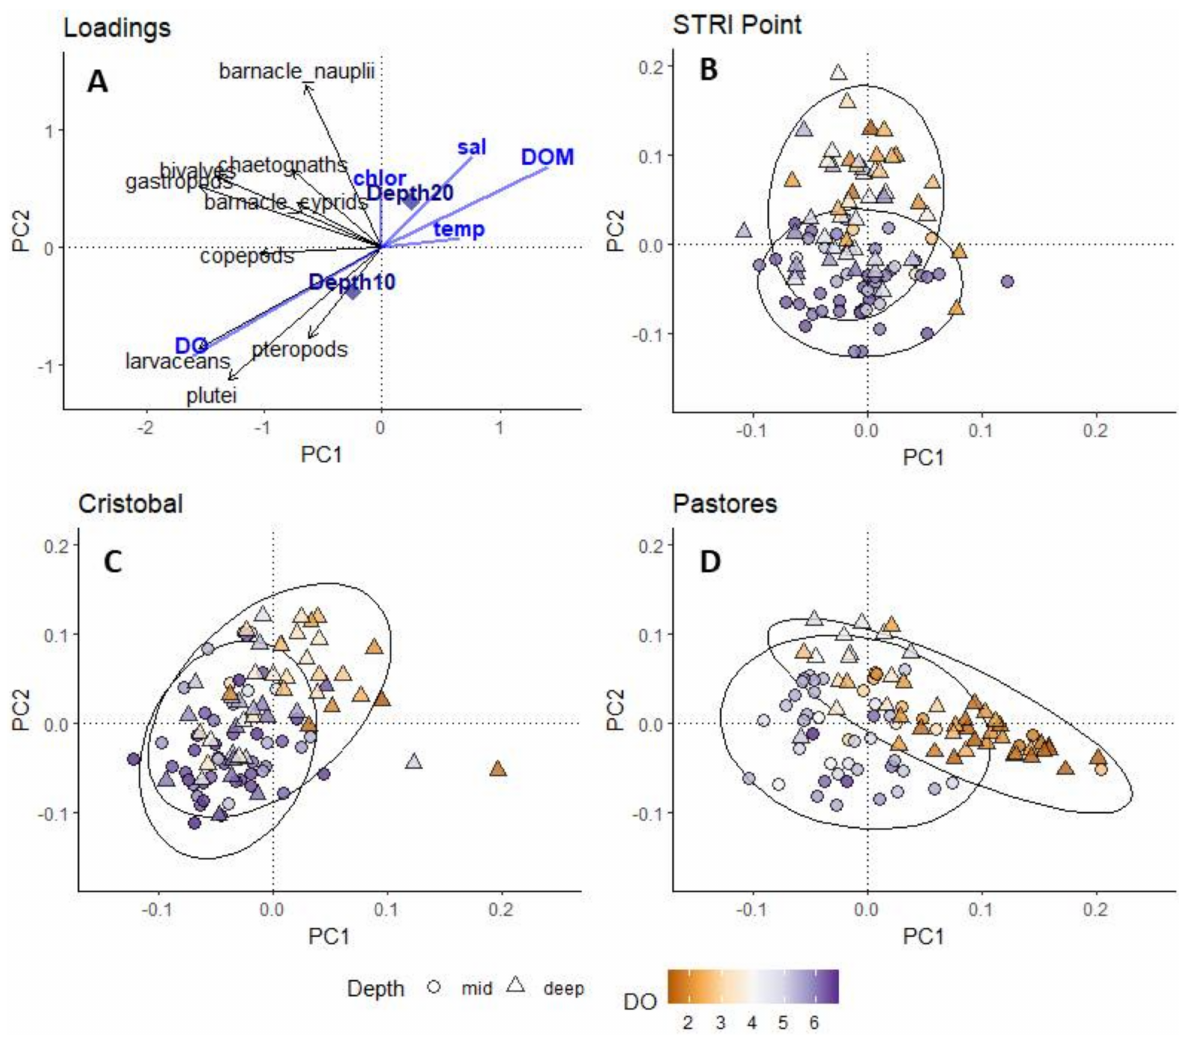
Figure 7. Results of a single principal component analysis of the entire plankton community ( A ), plotted separately for each site [STRI Point ( B ), Cristobal ( C ), and Pastores ( D )]. Environmental parameters, mapped onto community ordination, are shown in blue as vectors (continuous variables) and points (categorical variable; depth). Points in site-specific plots are colored by oxygen content, and point shapes denote sample